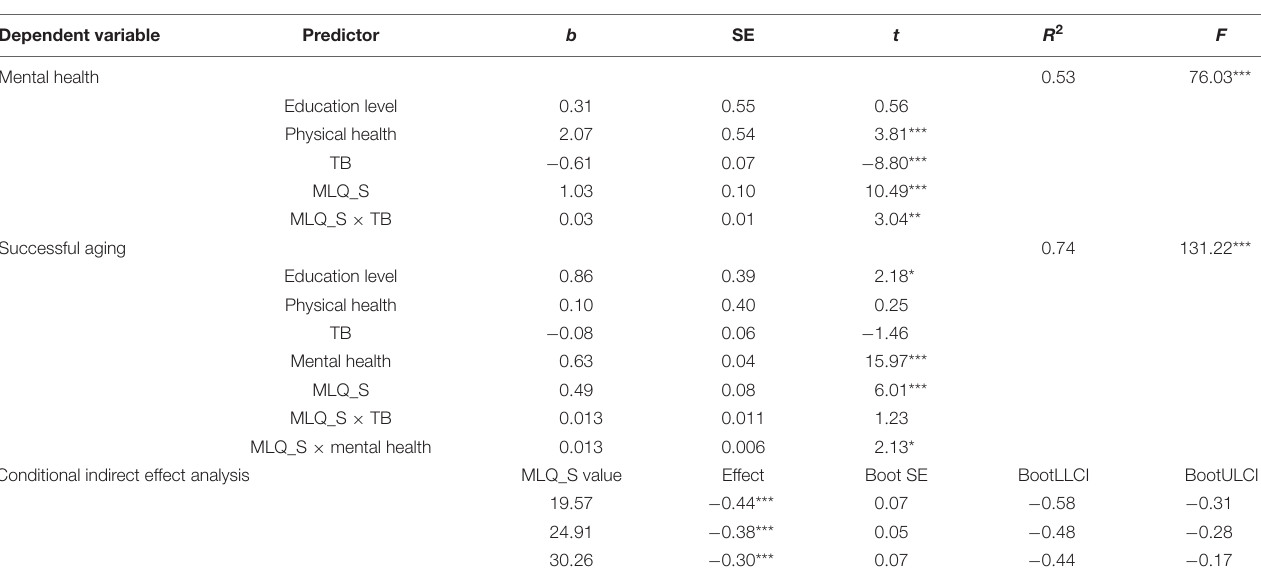
FIGURE 2 | MLQ_P and MLQ_S moderated the pattern of relationships between thwarted belongingness, mental health, and successful aging. (A) The moderating effect of MLQ_P on the link between thwarted belongingness and mental health; (B) the moderating effect of MLQ_P on the link between mental health and successful aging; (C) the moderating effect of MLQ_S on the link between thwarted belongingness and mental health; (D) the moderating effect of MLQ_S on the link between mental health and successful aging. TB, thwarted belongingness; MLQ_P, presence of meaning; MLQ_S, search for meaning; PMH, positive mental health. TABLE 4 | Testing the moderated mediation effect (MLQ_S as a